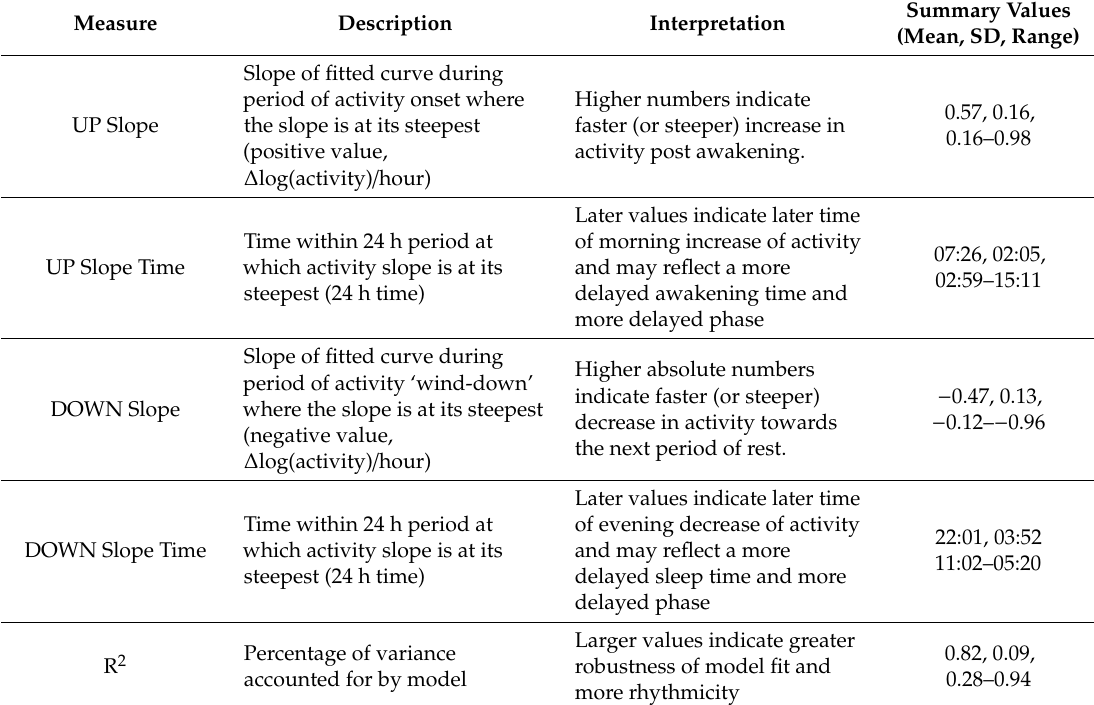
Table 2. Proposed outcome variables derived from graphical approach in the lifestyle sample (N =